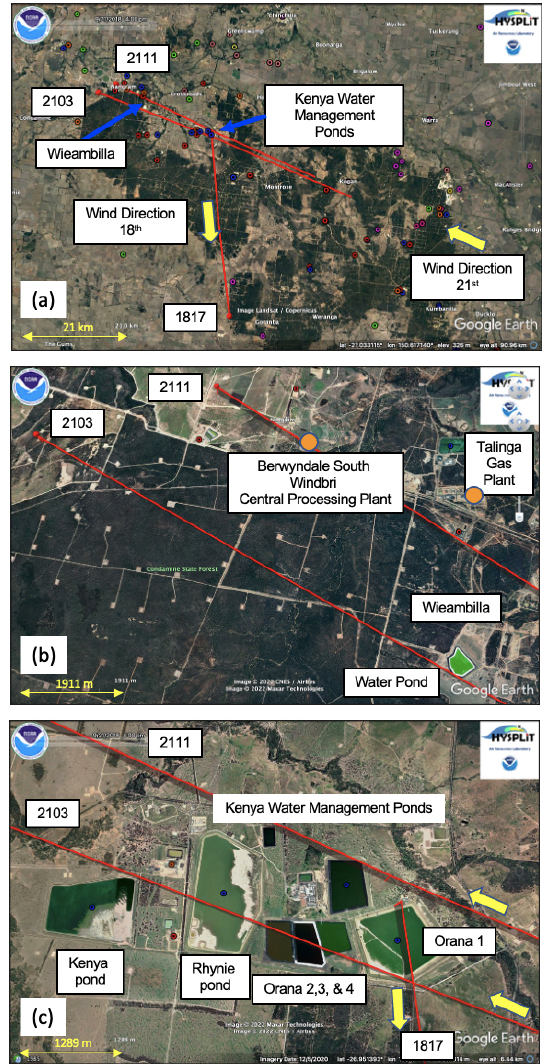
Figure 8. (a) Two-hour back-trajectory path lines for IFAA sam- ples 1817, 2103, and 2111. (b) Back-trajectory paths for 2103 and 2111 relative to the Berwyndale South/Windbri central processing plant and the Talinga processing plant. (c) Kenya water manage- ment ponds relative to 1817, 2103, and 2111 back-trajectory centre lines. The yellow arrows show the wind direction for each trajectory. Refer to Fig. A1 for the point source colour key (image © Google